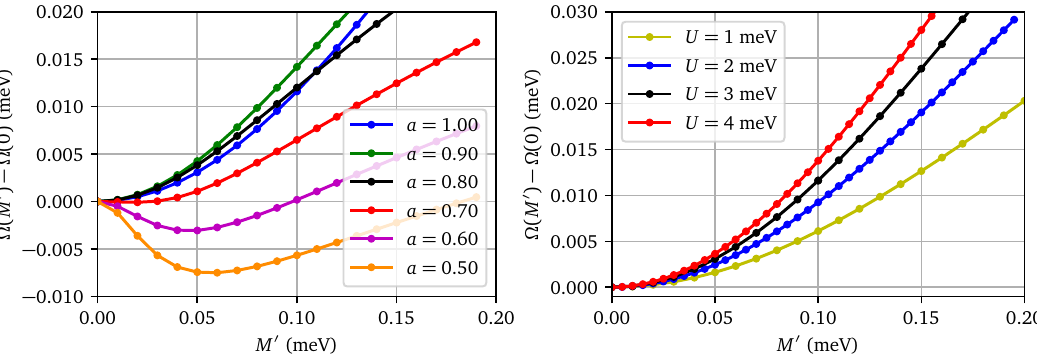
Figure 7: Left panel: Potthoff functional vs the antiferromagnetic Weiss field M several values of a = 3 V / 2 U and U = 3 meV, at half-filling. The case a = 1 cor- 1 responds to the constraints (5), and smaller values of a just weaken the extended interactions compared to the on-site interaction. The value of Ω at M = 0 is sub- tracted for clarity. Antiferromagnetism appears only below a = 0.7, i.e., not for the extended interactions constrained by Eq. (5). Right panel: same thing, but for a = 1 and different values of U . Antiferromagnetism does not occur in the range of U